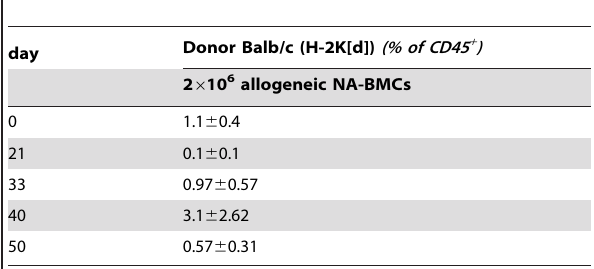
Table 2. Analysis of donor Balb/c (H-2K[d]) chimerism after transplantation of 2 6 10 6 allogeneic